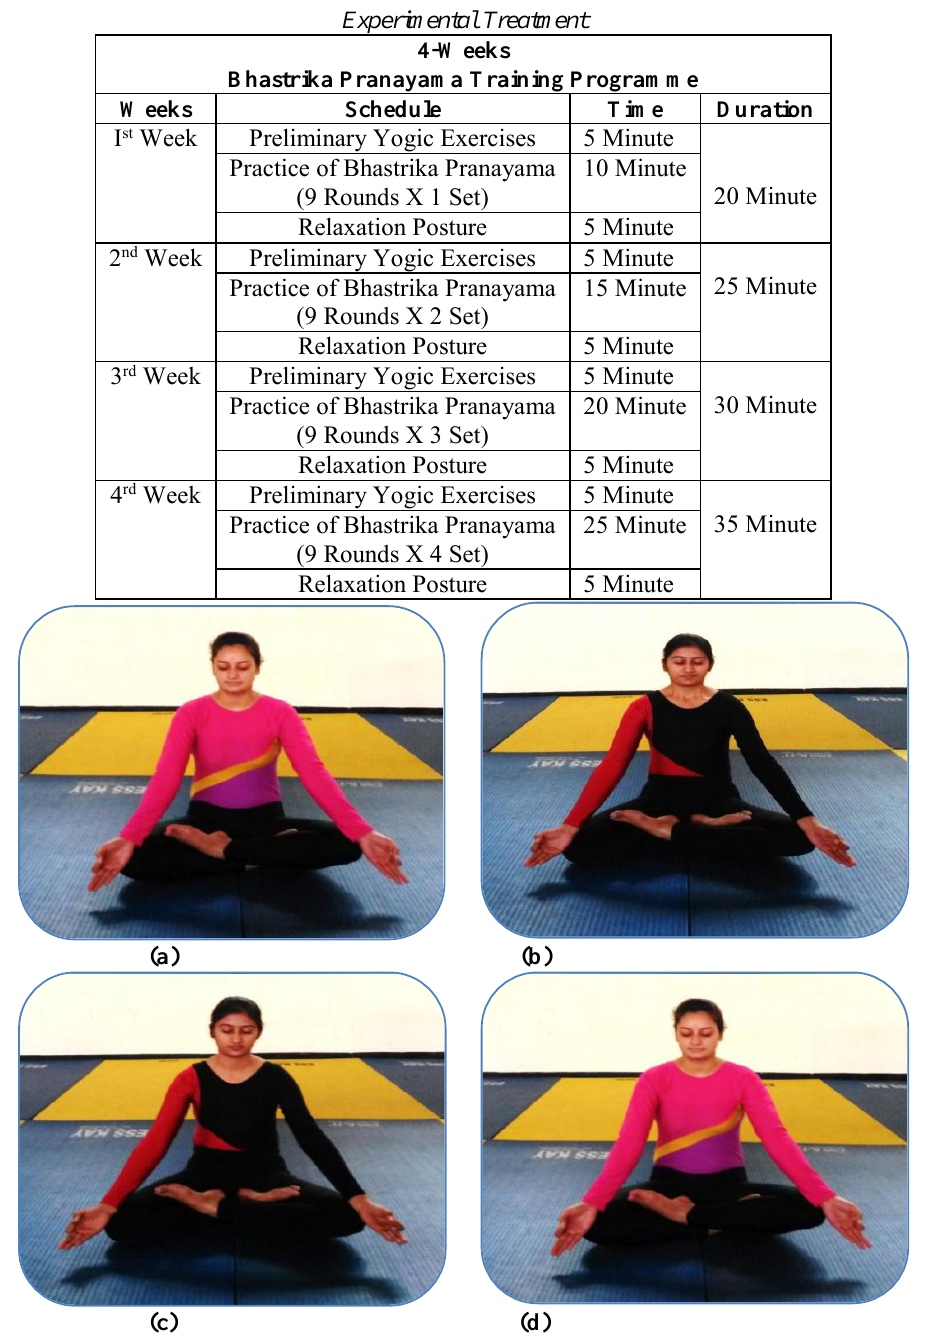
Fig. 7. Subjects Performing Bhastrika